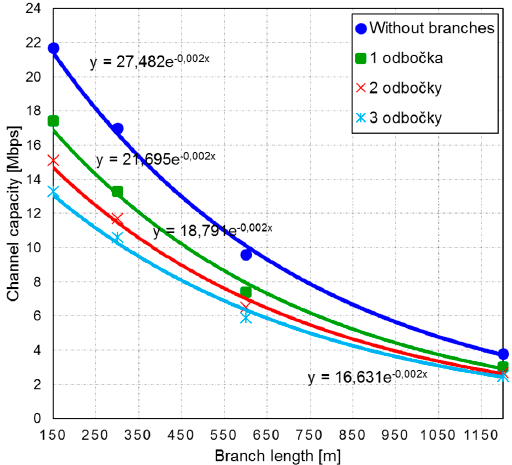
Figure 6. Channel capacity for a NAYY150SE cable with varying length from transmitter to receiver and a varying number of branches.